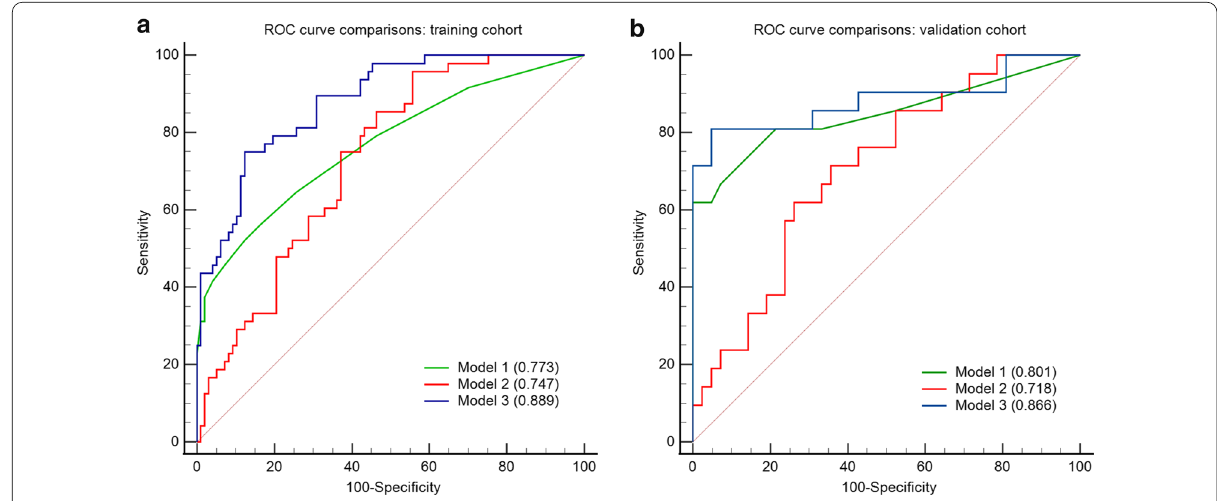
Fig. 4 Comparison of receiver operating characteristics curves of the three models in training ( a ) and validation ( b )